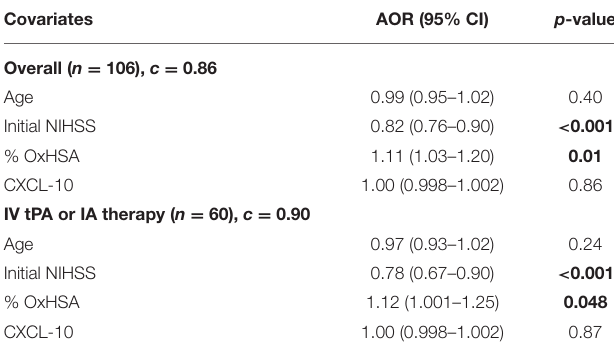
TABLE 1 | Correlation coefficients and p -values. Spearman or Pearson correlation coefficient